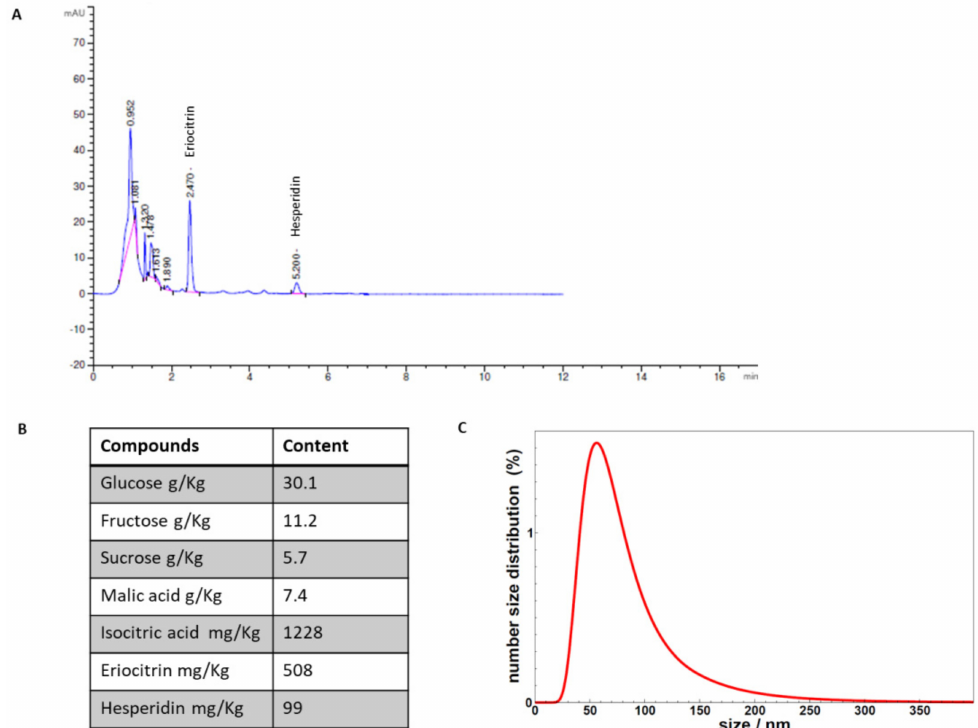
Figure 1. ( A ) The chromatographic analyses of the compounds identified in the supplement. ( B ) Quantitative data of the compounds quantified in the supplement. ( C ) DLS analysis of vesicles contained in the